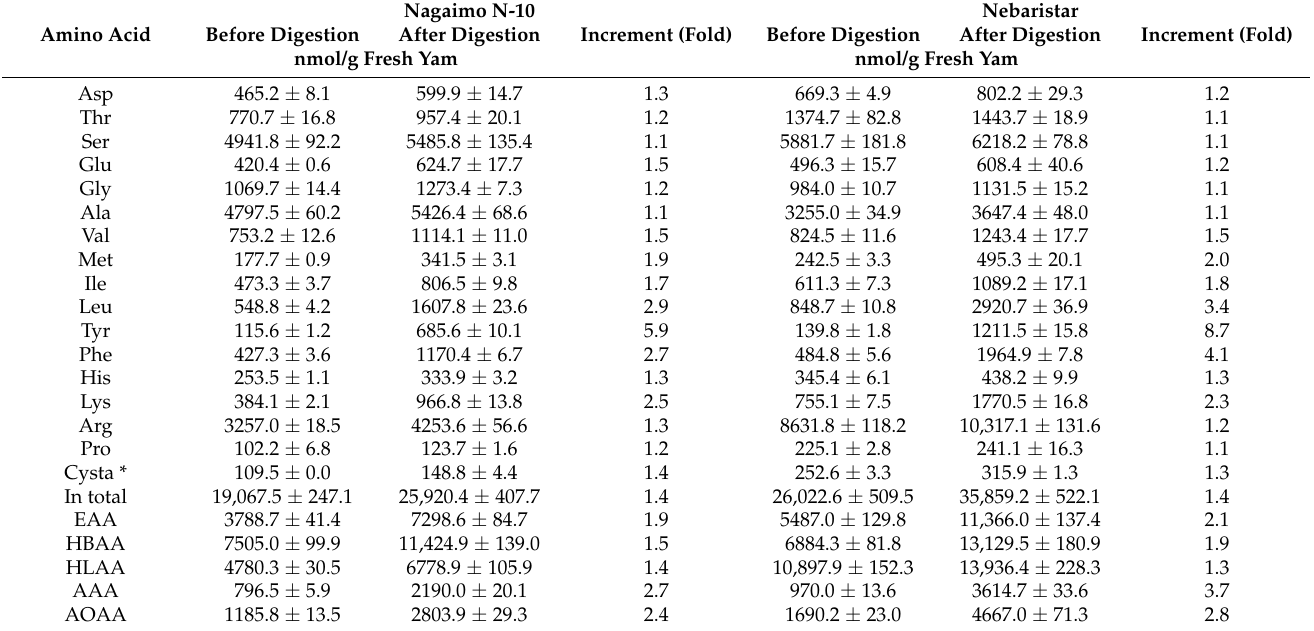
Table 1. Release of free amino acids in yam tubers during simulated in vitro digestion. Nagaimo